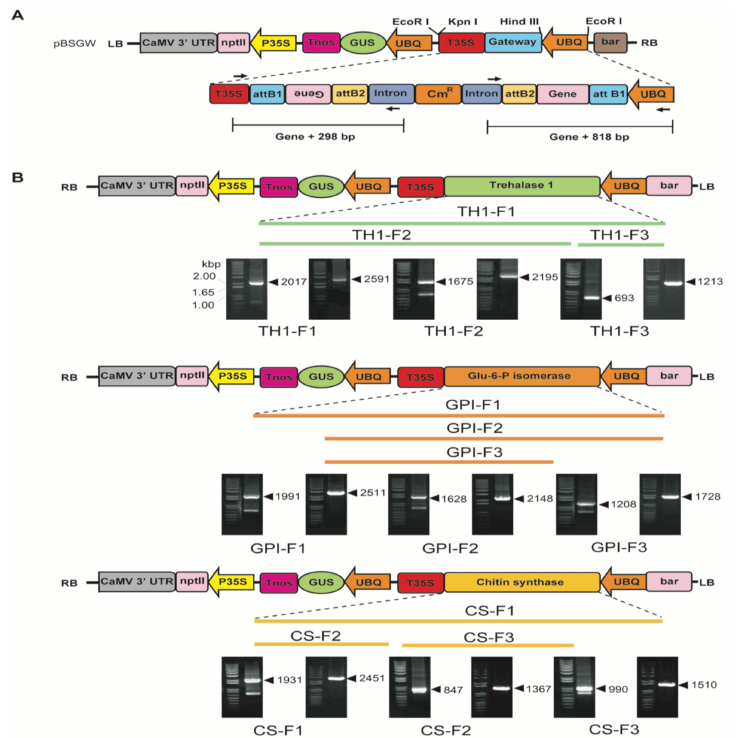
Figure 2. Chitin biosynthesis pathway genes for RNAi vector construction. ( A ) Schematic representation of the vector intended for tobacco transformation. The GATEWAY cassette composed of two recombination sites (attB1 and attB2, two intron sequences, a chloramphenicol-resistance gene (Cm R ), and the ccdB gene). ( B ) The expression cassette is located between the left and right T-DNA boarders (LB and RB, respectively) and contains two marker genes, a reporter gene along with the desired gene (kanamycin), phosphinothricin-resistance gene (bar), and GUS. Expression of the selection markers and GUS was under the control of the cauliflower mosaic virus 35S promoter and the Arabidopsis ubiquitin promoter (UBQ), respectively. Along with selection and reporter genes harboring CaMV 3 (cid:48) UTR and nopaline synthase terminators, the desired cDNAs trehalase 1, GPI, and CS were under the control of the Arabidopsis ubiquitin promoter with the 35S